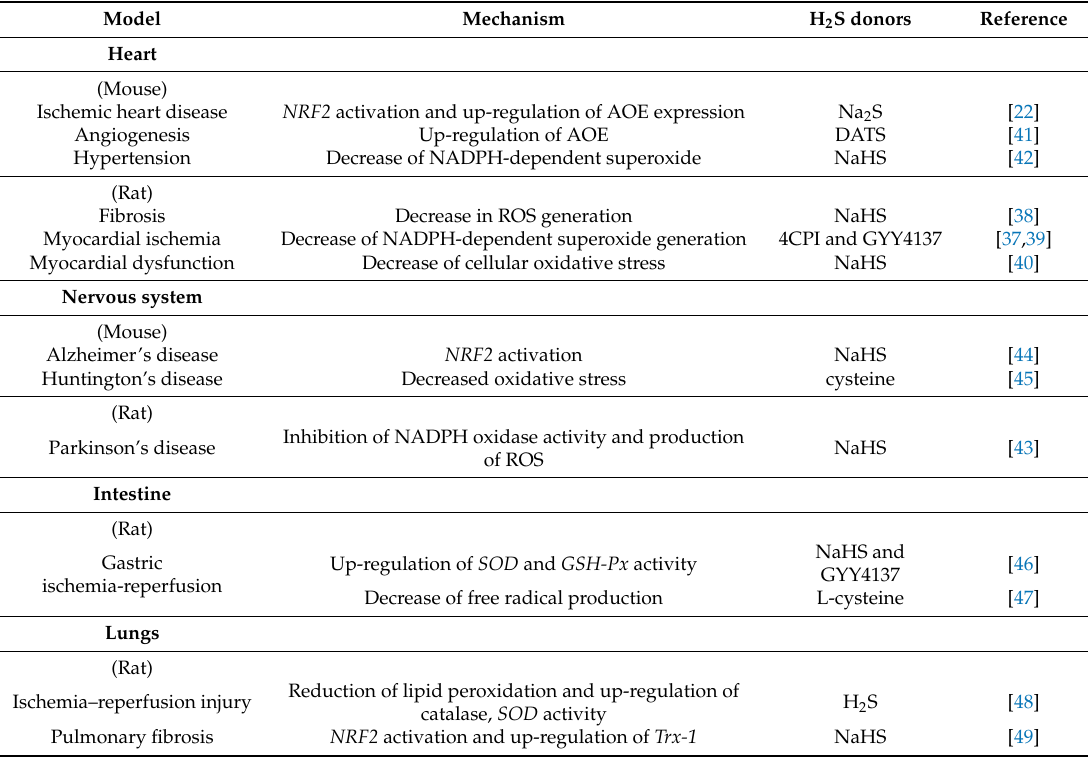
Table 1. Beneficial role of H 2 S donors in animal models of oxidative stress-dependent